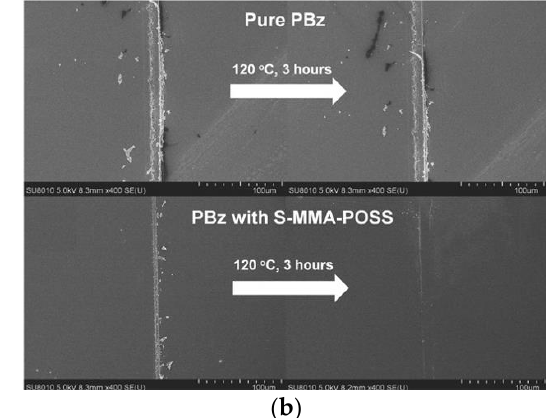
Figure 25. Comparison of ( a ) SEM micrographs of POSS-MMA-S samples before and after the self- healing process at 120 °C for 1 h and 3 h; ( b ) self-healing abilities of pristine PBz and PBz/POSS- MMA-S films. Copyright (2017) Wiley. Used with permission from (Lin, H.-K.; Liu, Y.-L., Reactive Hybrid of Polyhedral Oligomeric Silsesquioxane (POSS) and Sulfur as a Building Block for Self- Healing Materials, Macromol. Rapid Commun . 2017, 38 , 1700051; WILEY-VCH Verlag GmbH & Co. KGaA, Weinheim) [85].